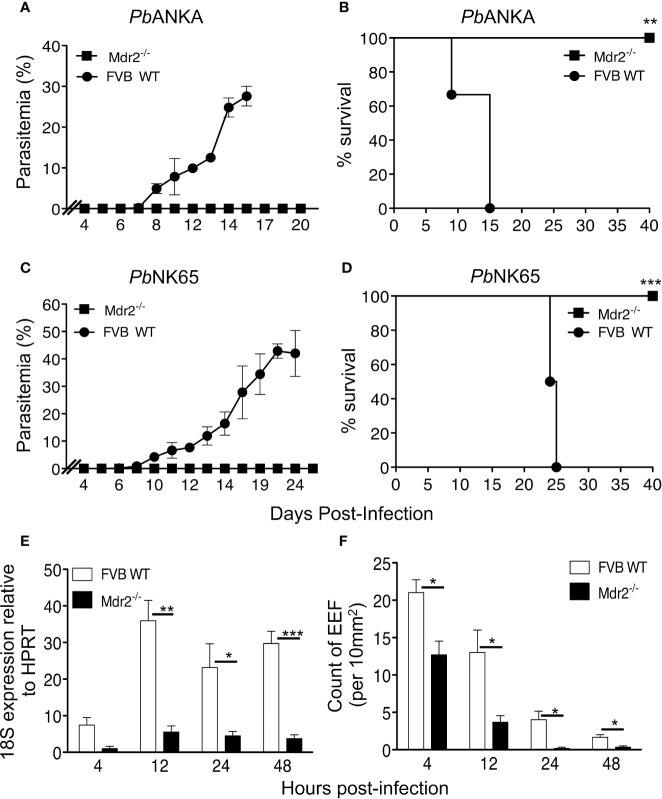
Mdr2−/− mice do not develop blood stage parasites. Parasitemia and survival of infected WT FVB and Mdr2−/− mice. Six-week-old WT FVB and Mdr2−/− mice (n = 6 per group) were naturally infected by the exposure to bites of 10 Anopheles infected with PbANKA (A, C) or PbNK65 (B, D). Survival rate (Kaplan–Meier survival rates, Mantel–Cox test **p = 0.0012; ***p = 0.0009) and parasitemia were recorded over time. Results are from two independent experiments. (E) Real time qPCR (RT-qPCR) quantification of parasite ribosomal RNA 18s into 6-week-old female WT FVB and Mdr2-/- mice 4, 12, 24 and 40 h after infection with 104 SPZ (n = 5 per group). RT-qPCR was performed using standard SyberGreen protocols on total liver RNA. (F) Quantification by ex vivo microscopy of exoerythrocytic forms (EEFs) in livers of 6-week-old female WT FVB and Mdr2−/− mice injected i.v. with 5 × 104
PbANKA SPZ 4, 12, 24 and 40 h post infection (n = 5 per group). EEFs were counted on 20 fields (objective × 10) and normalized by 10 mm2 of liver section. Results are from two independent experiments (Mann–Whitney test; *p < 0.05; **p < 0.01; ***p < 0.001).